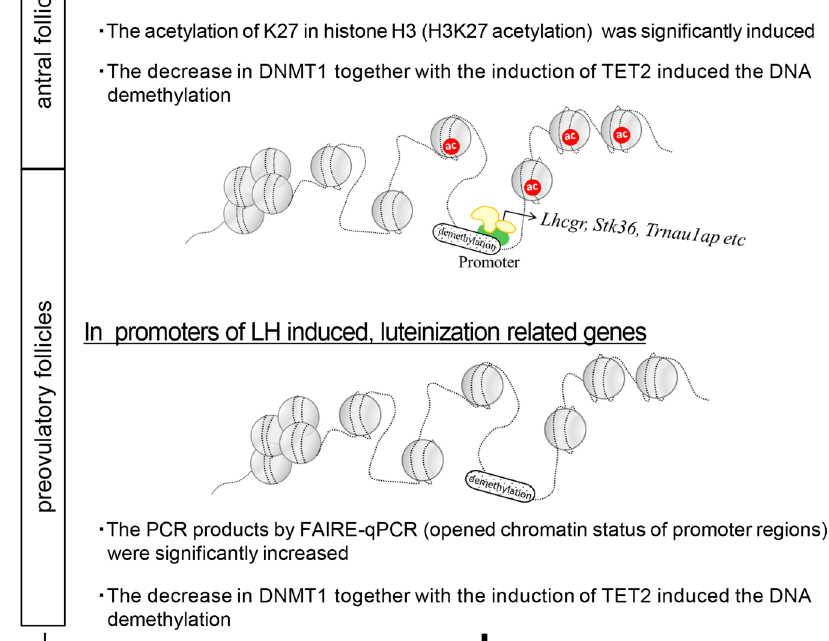
Fig. 8 A schematic of epigenetic-related mechanisms in granulosa cells during follicular development process. DNA demethylation and histone modi fi cation contribute to changes in gene expression as proliferating granulosa cells undergo progressive differentiation during follicular maturation.